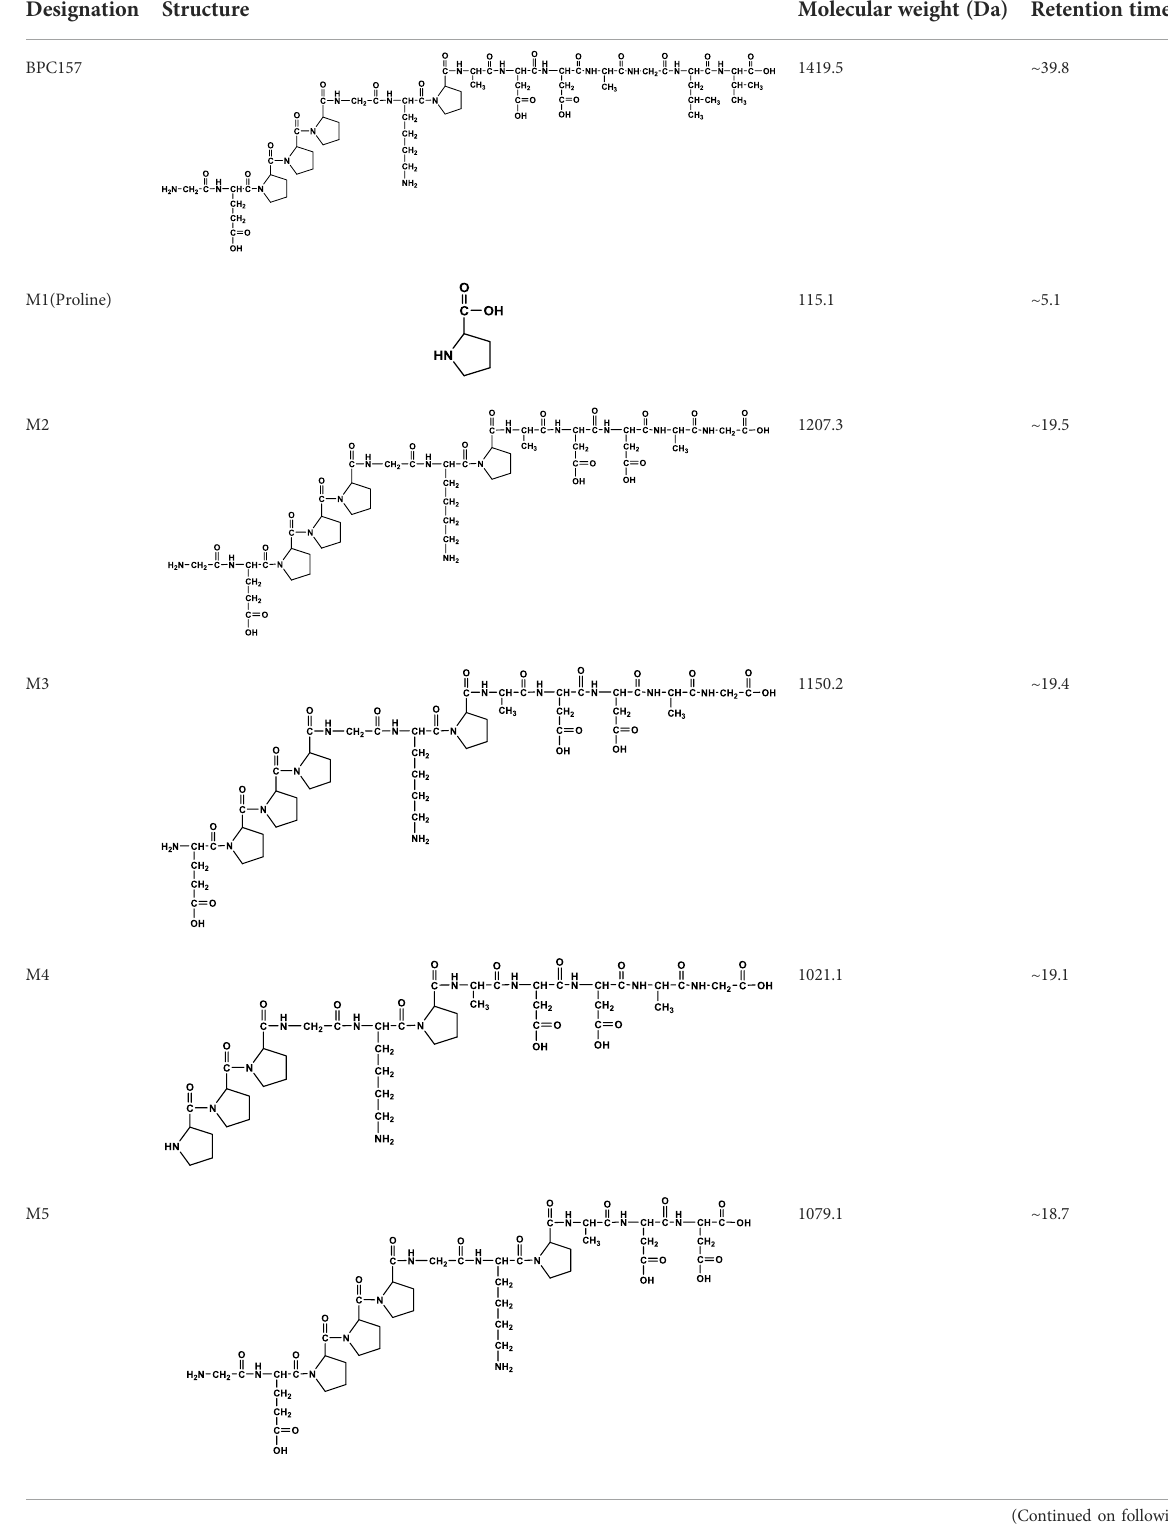
TABLE 10 Structures of six metabolites identi fi ed by high-performance liquid chromatography-tandem mass spectrometry in rat plasma, bile, urine, and feces following a single intramuscular administration of 100 µg/300 μ Ci/kg of